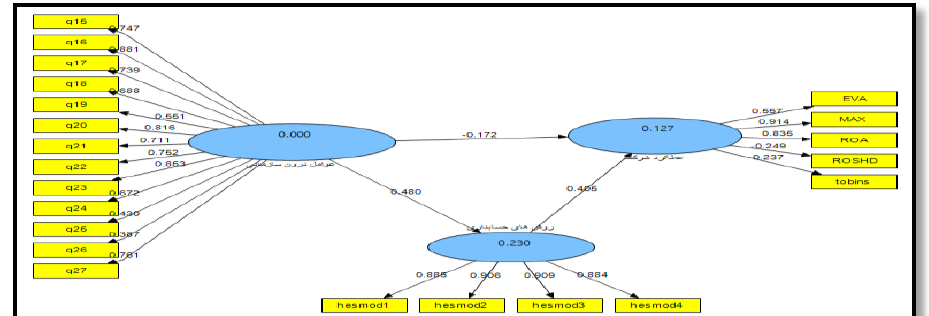
Figure 5. The model path